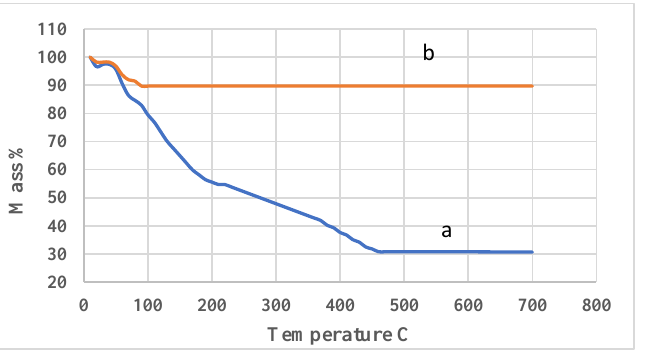
Figure 5. Atomic force microscope image of ( a ) CMOISW and ( b ) thermally cured OISW car- boxymethylated OISW.